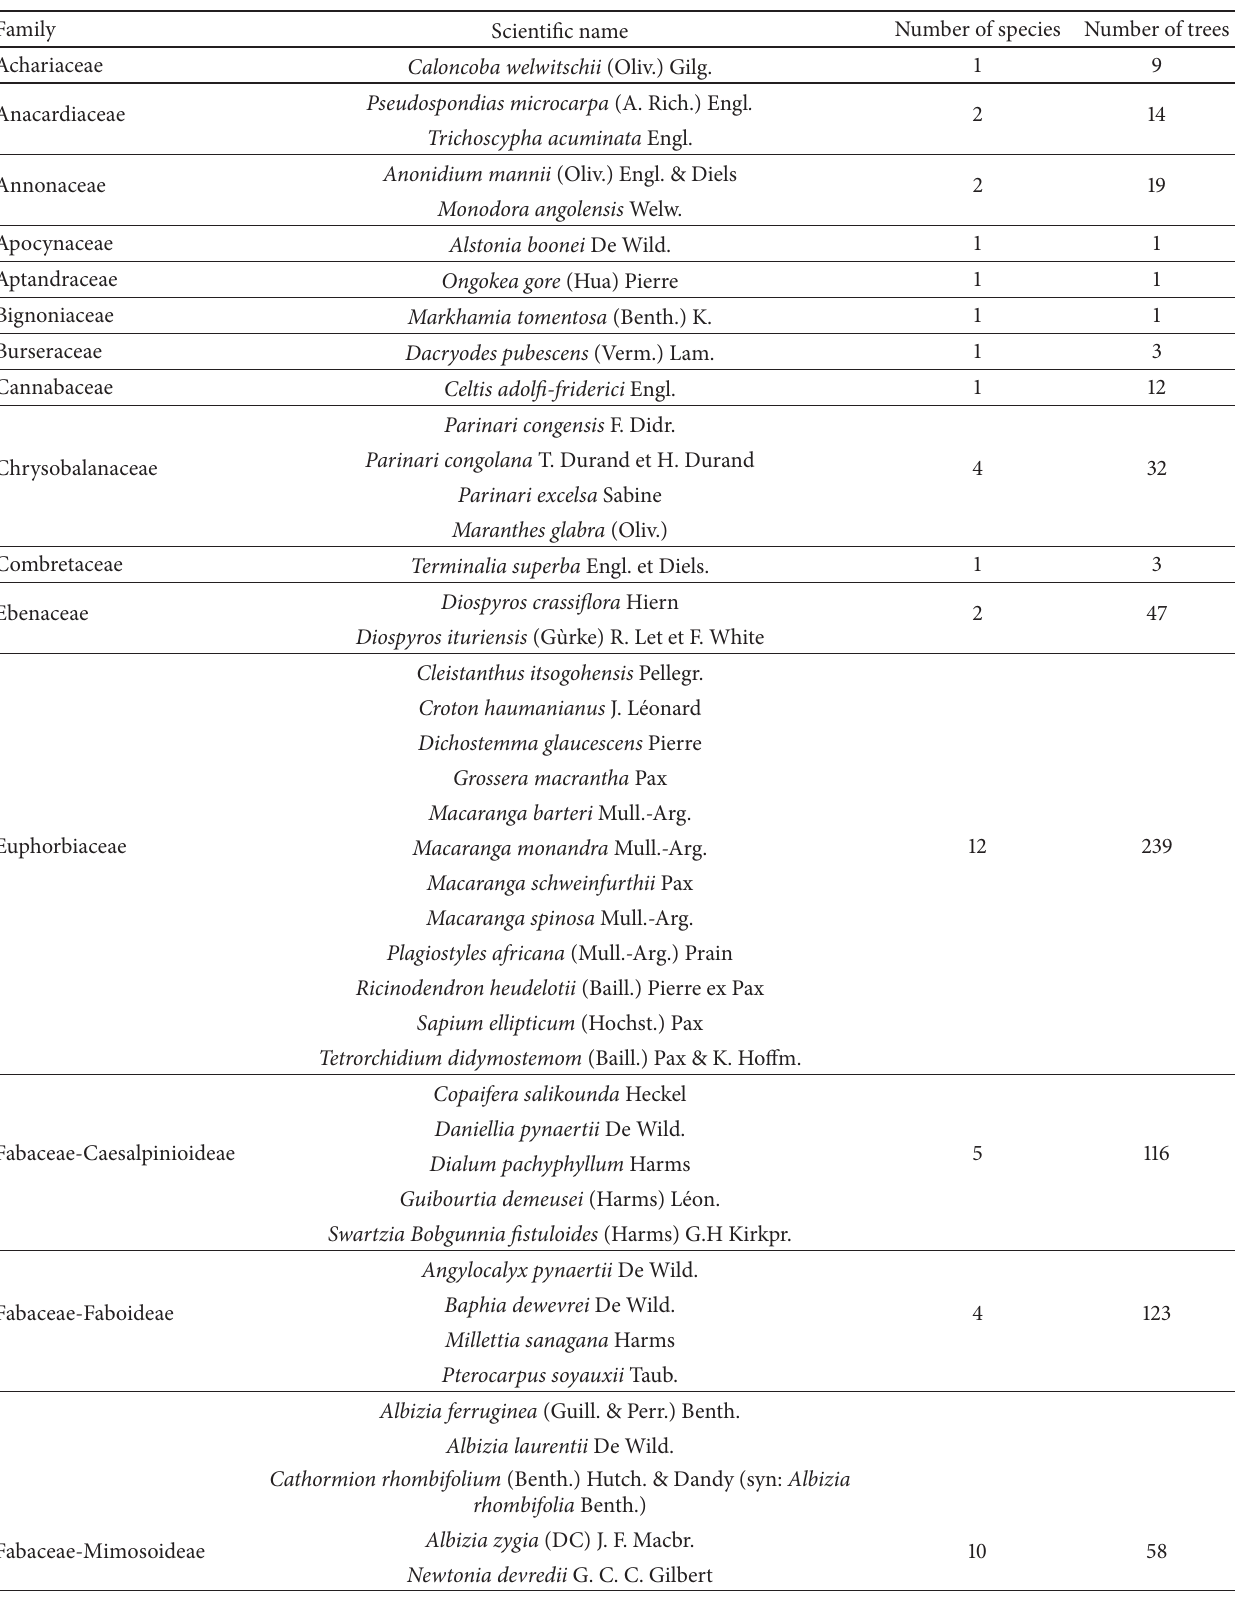
Table 2: Floristic lists and their frequencies of the study